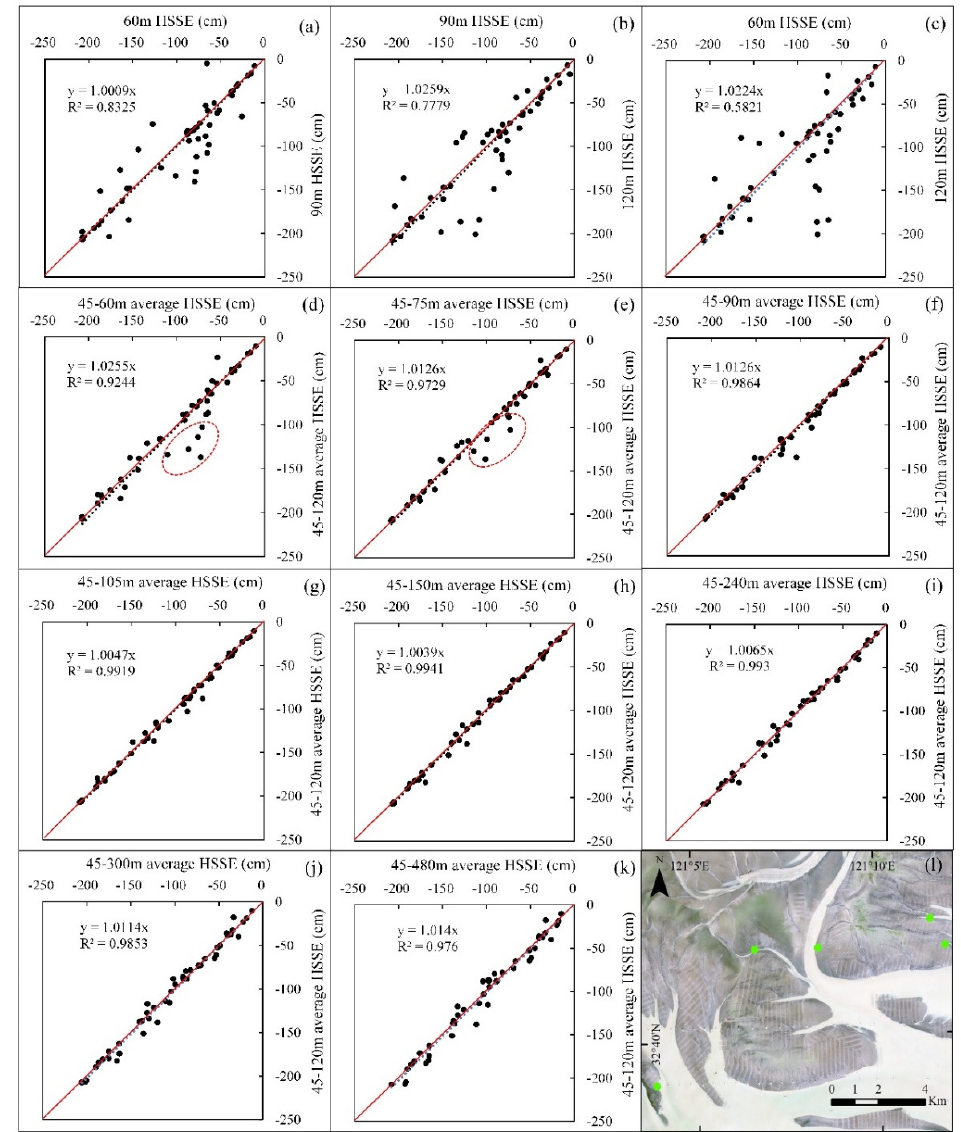
Figure 11. Correlation analysis for HSSE results under different scenarios. ( a – c ) are the comparison under the single smoothing window. ( d – k ) are the comparison between the different average schemes and our adopted average scheme. ( l ) displays the actual locations of the five scattered points in ( d , e